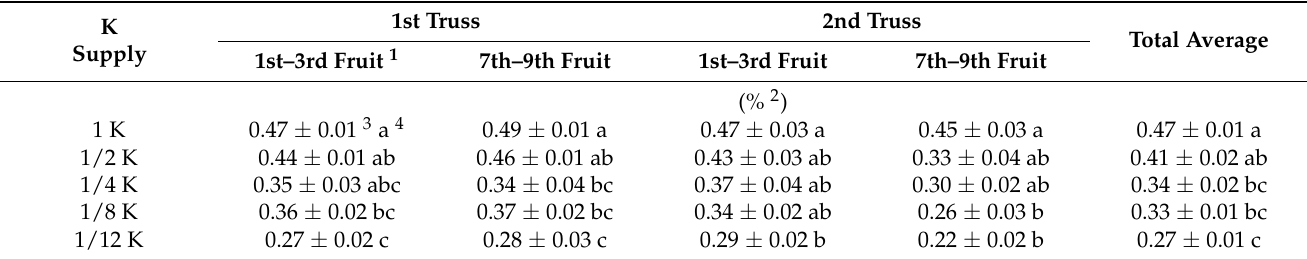
Table 6. Fruit acid content of hydroponically grown cherry-type tomato ‘Carol 10’ under five quantitative K-supply regimes. K